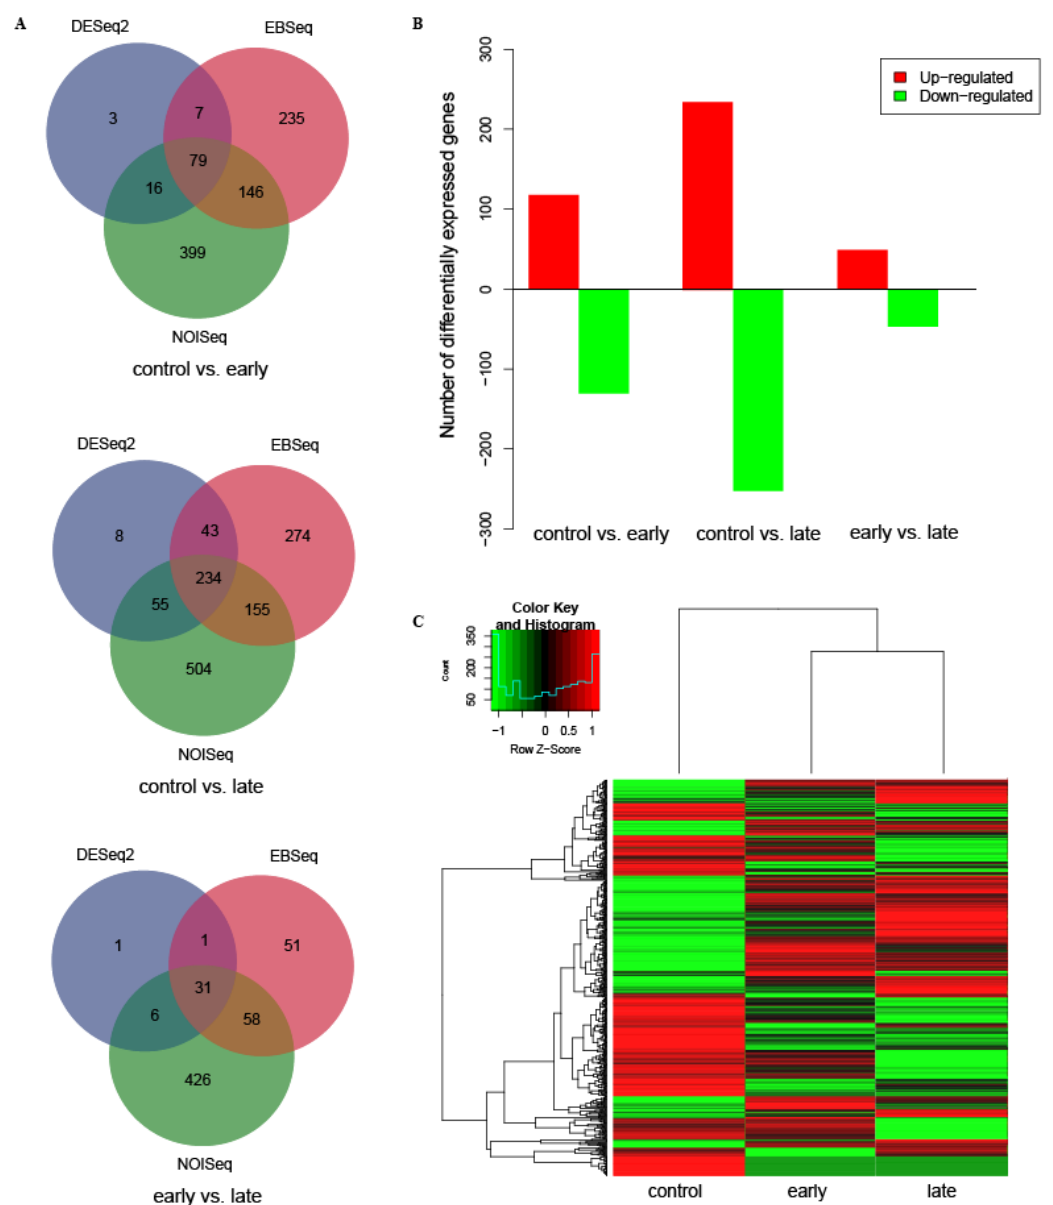
Figure 1. Summary of DEGs identified by three analysis methods within three comparative groups. ( A ) The number of DEGs identified by three analysis methods in the three comparative groups. ( B ) The number of up-regulated and down-regulated genes in the three comparative groups. ( C ) A hierarchical clustering of DEGs identified in the three comparative groups. Scale of the color bar represents fold changes of transcription levels.